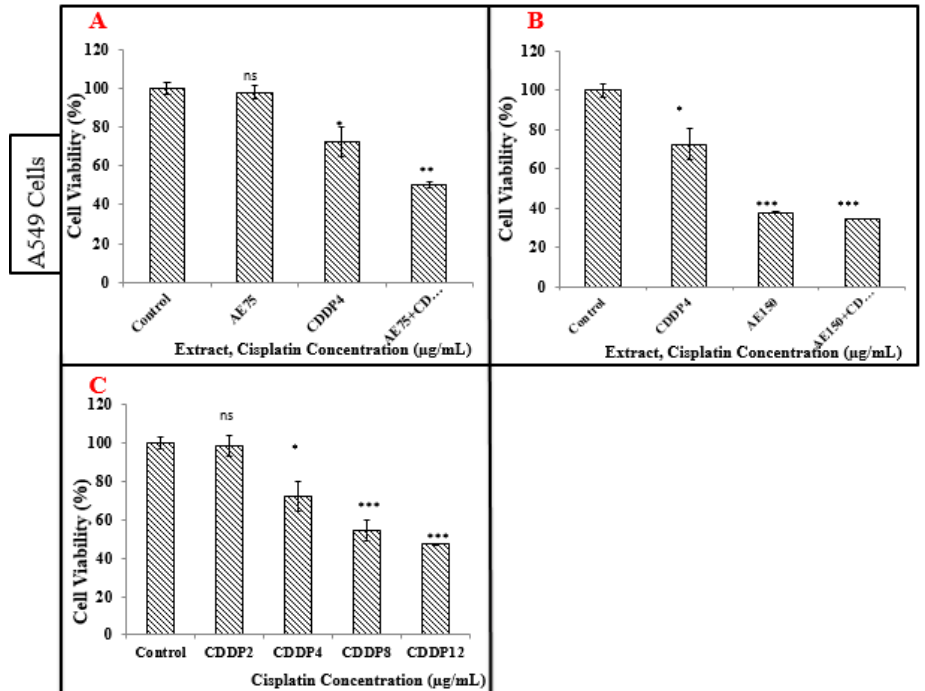
Figure 5. Cell viability of A549 after treatment for 24 h. ( A ) Cell viability of A549 for 24 h after treatment with CDDP (4 µ g / mL) combined with the aqueous extract (AE 75 µ g / mL), (MTT). ( B ) Cell viability of A549 for 24 h after treatment with CDDP (4 µ g / mL) combined with the aqueous extract (AE 150 µ g / mL), (MTT). ( C ) Cell viability of A549 cells after treatment with increasing concentrations of CDDP for 24 h (* p < 0.05, ** p < 0.01, *** p < 0.001, **** p < 0.001).